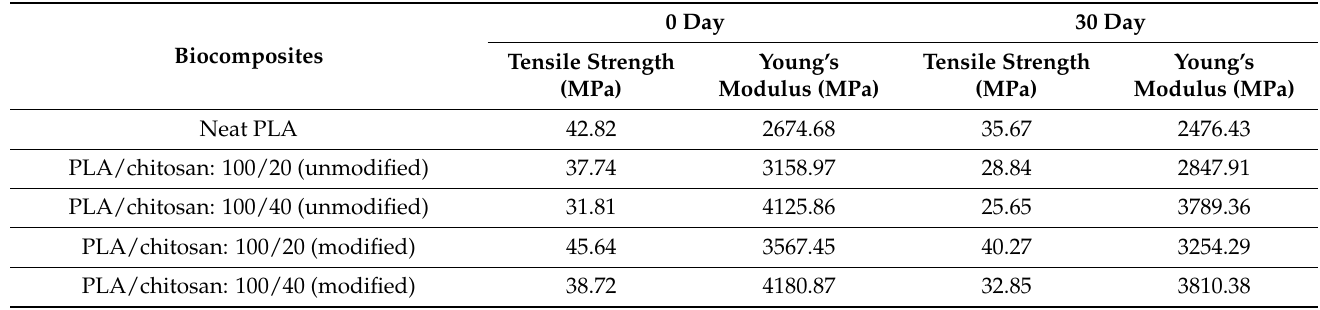
Table 5. Tensile strength and Young’s modulus of neat PLA, PLA/chitosan biocomposites, with and without treatment, at 0- and 30-day biodegradation